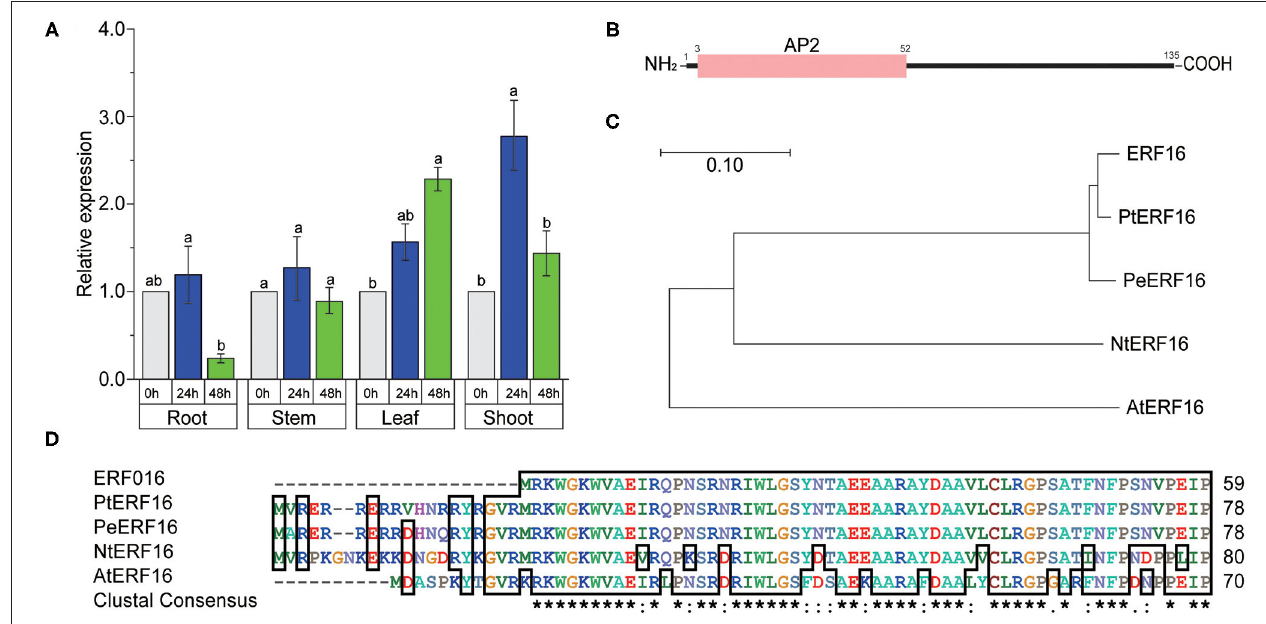
FIGURE 1 | Spatio-temporal expression pattern and sequence alignment of PagERF16 . (A) Relative expression of PagERF16 in roots, stems, leaves, and shoots, respectively, under 100mM NaCl. Different lowercases above the bar chart indicate significant differences among samples ( p ≤ 0.05). (B) AP2 conserved domain architecture of PagERF16 of poplar. (C) Phylogenetic analysis of PagERF16 homologs in P. trichocarpa , P. euphratica , Nicotianu tabacum, and Arabidopsis thaliana . (D) Multiple sequence alignment of PagERF16 amino acid sequence of Populus trichocarpa , P. euphratica , Nicotianu tabacum, and Arabidopsis thaliana .